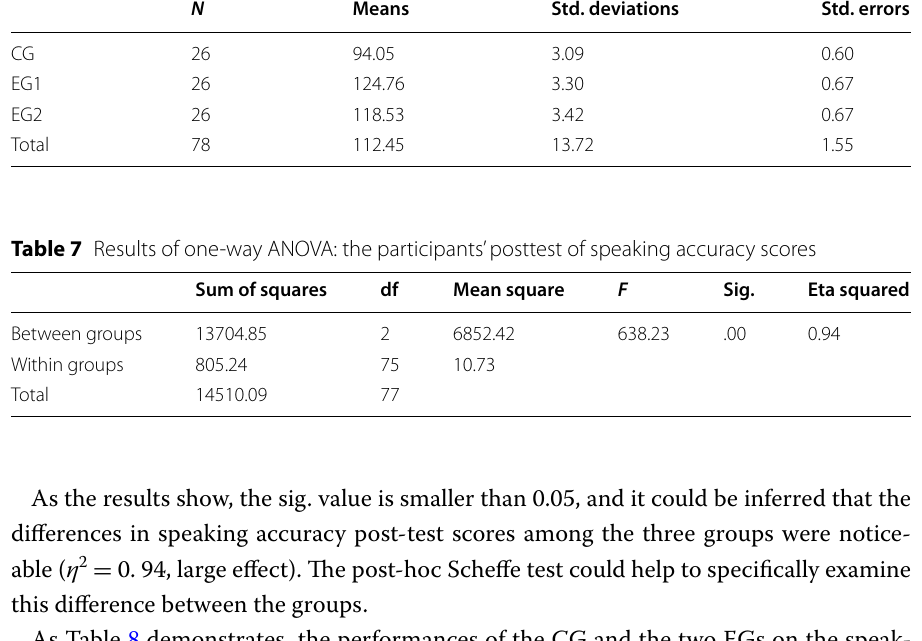
Table 6 Descriptive statistics: the participants’ post-test of speaking accuracy scores N Means Std. deviations